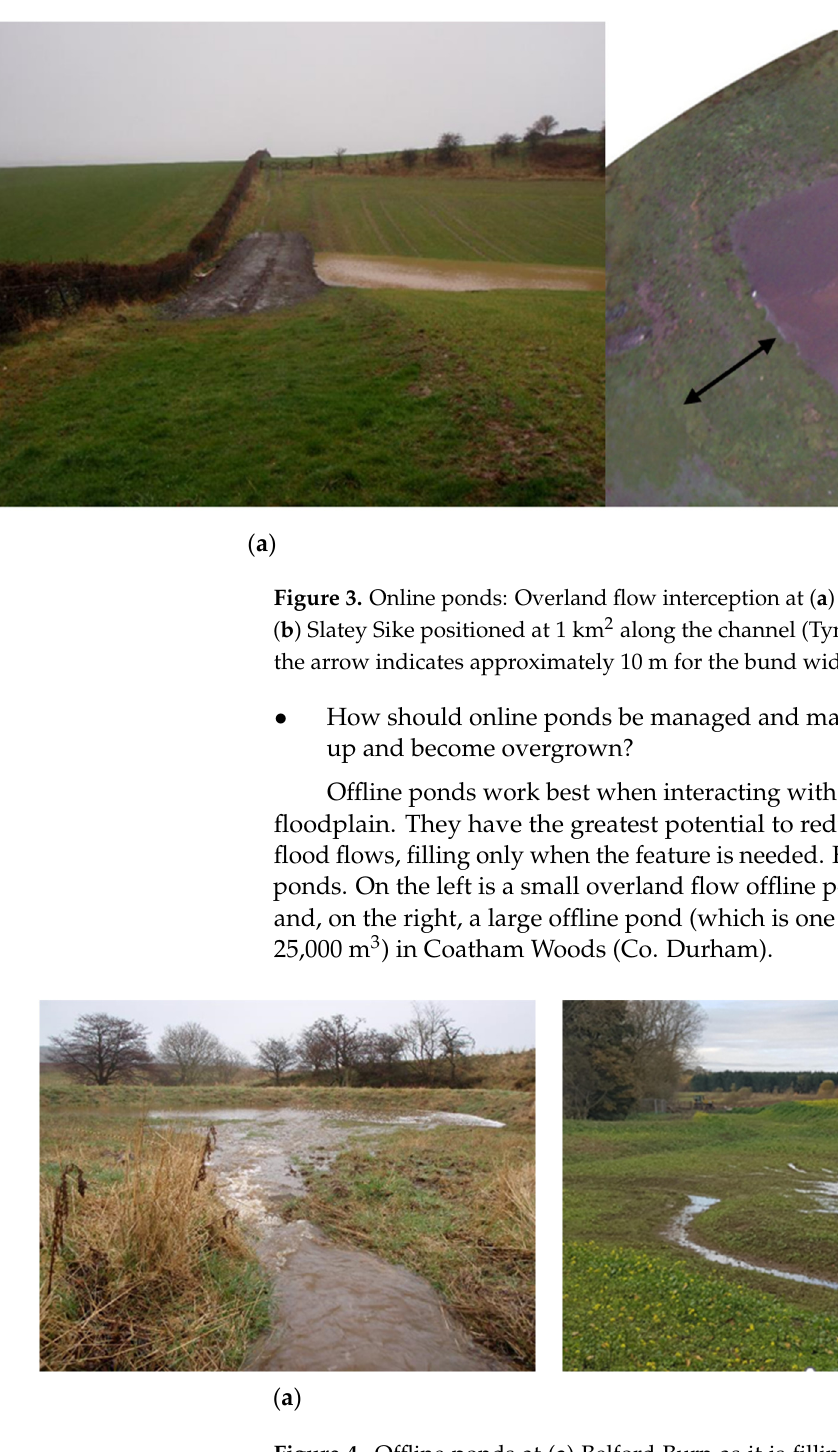
Figure 4. Offline ponds at ( a ) Belford Burn as it is filling and ( b ) Coatham Woods, Co. Durham, shortly after a storm